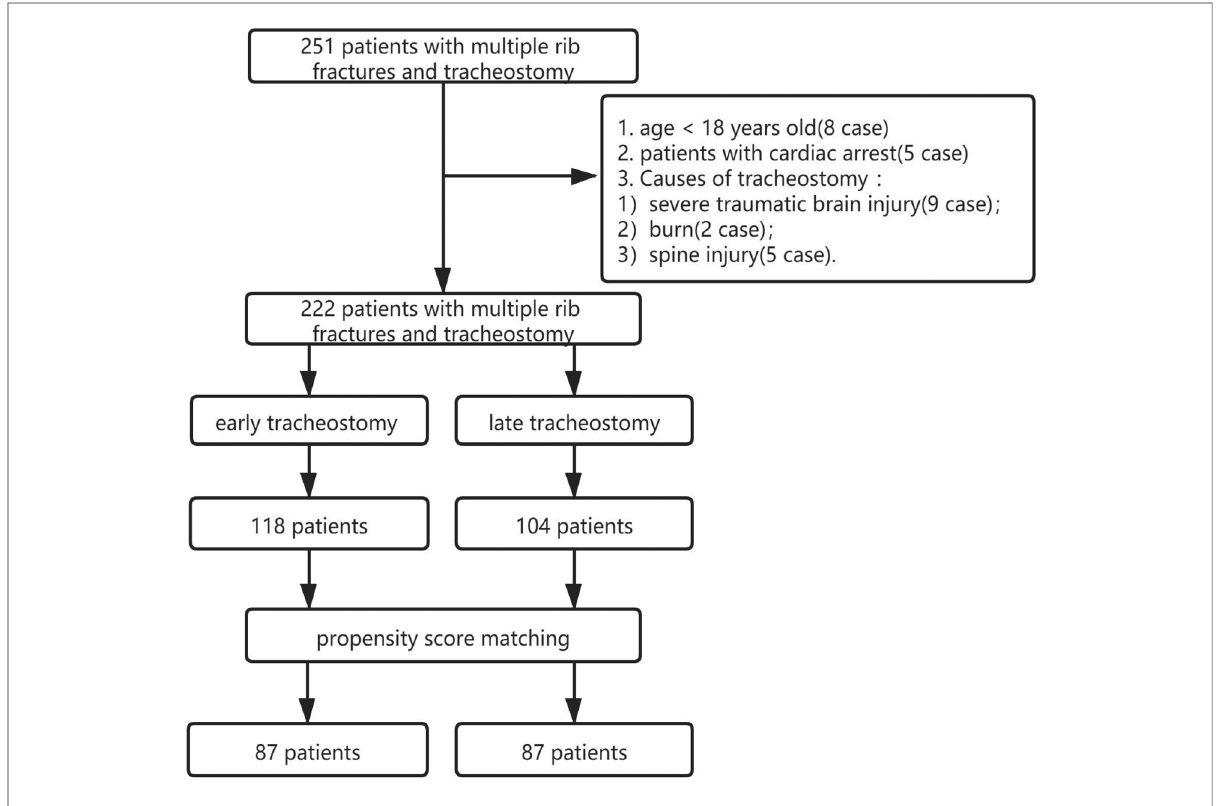
FIGURE 1 Flow chart of the study design and the patient